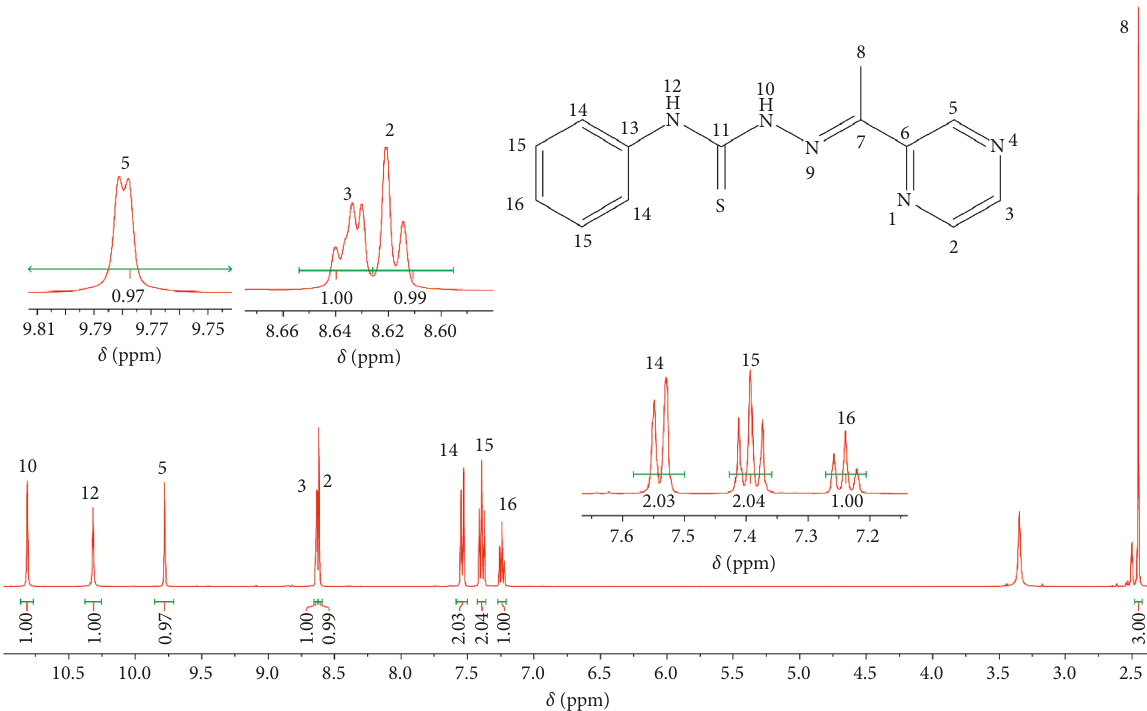
Figure 1: 1 H-NMR spectrum for H